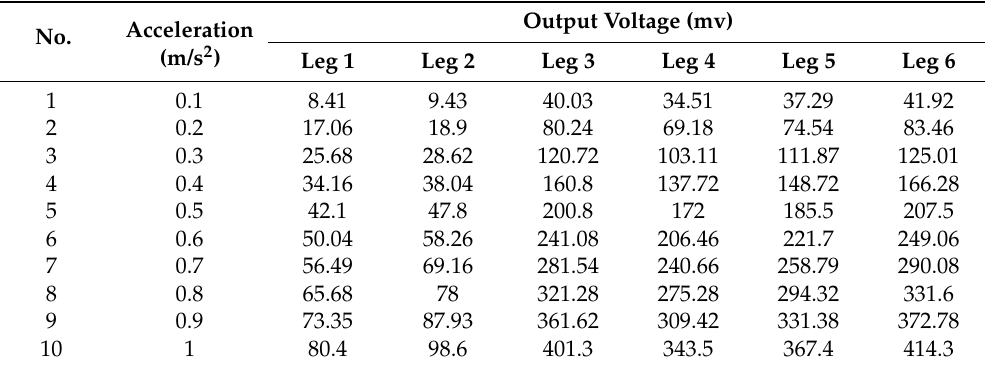
Table 4. Output voltage of each channel on x -axis acceleration.